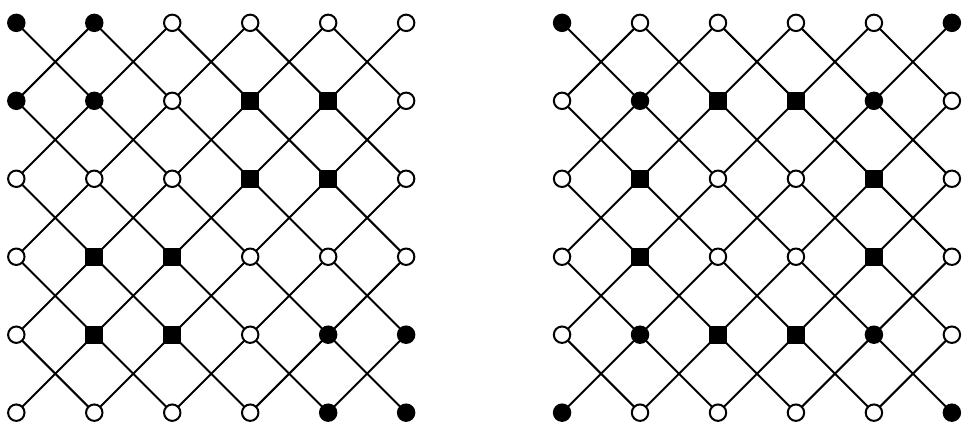
Figure 1. Two total Roman dominating functions on P 6 × P 6 where vertices in V 0 are white circles, vertices in V 1 are black circles and black squares represent vertices in V 2